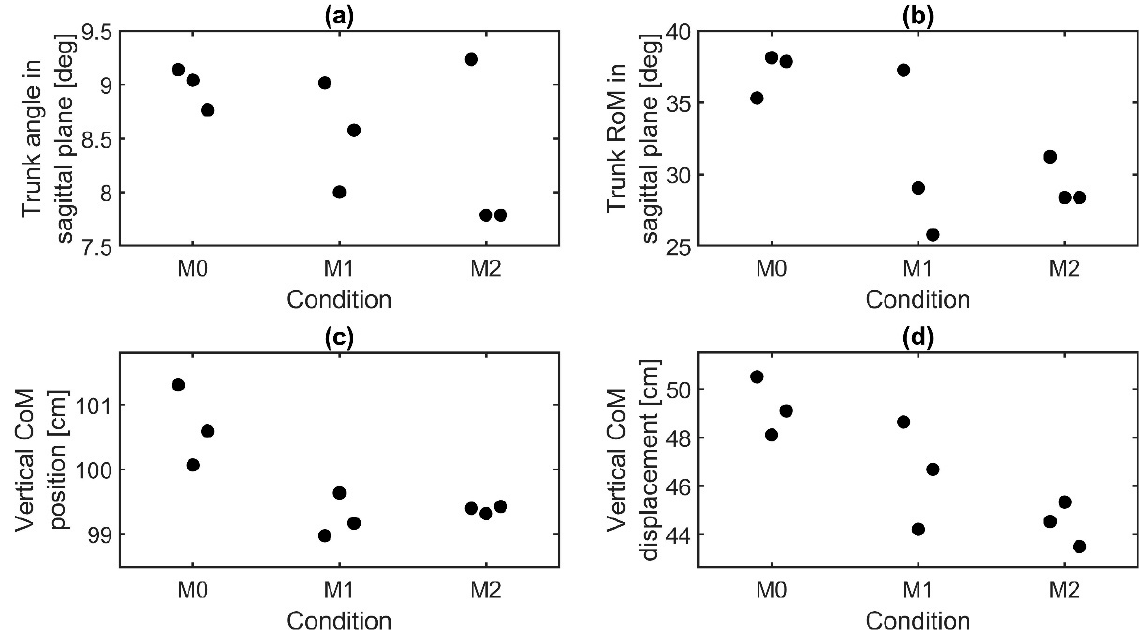
Figure 11. Results of kinematic parameters of subject 8 for three repetitions per condition. Median values are displayed. ( a ) Trunk angle in the sagittal plane, ( b ) trunk range of motion in the sagittal plane, ( c ) vertical position of the center of mass, and ( d ) vertical displacement of the center of mass.